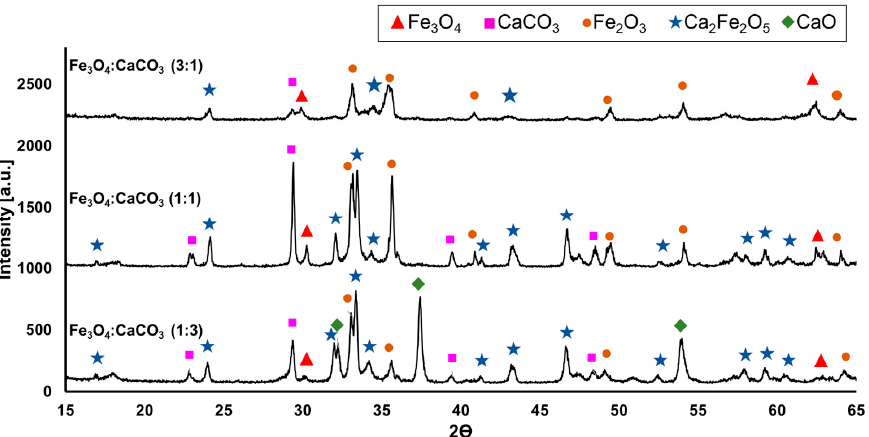
Figure 2. XRD pa tt erns for fl ame-spheroidised Fe 3 O 4 :CaCO 3 (mass ratios 3:1, 1:1 and 1:3).